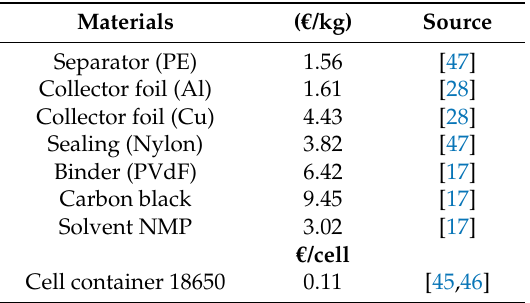
Table 3. Cost data for other battery materials.